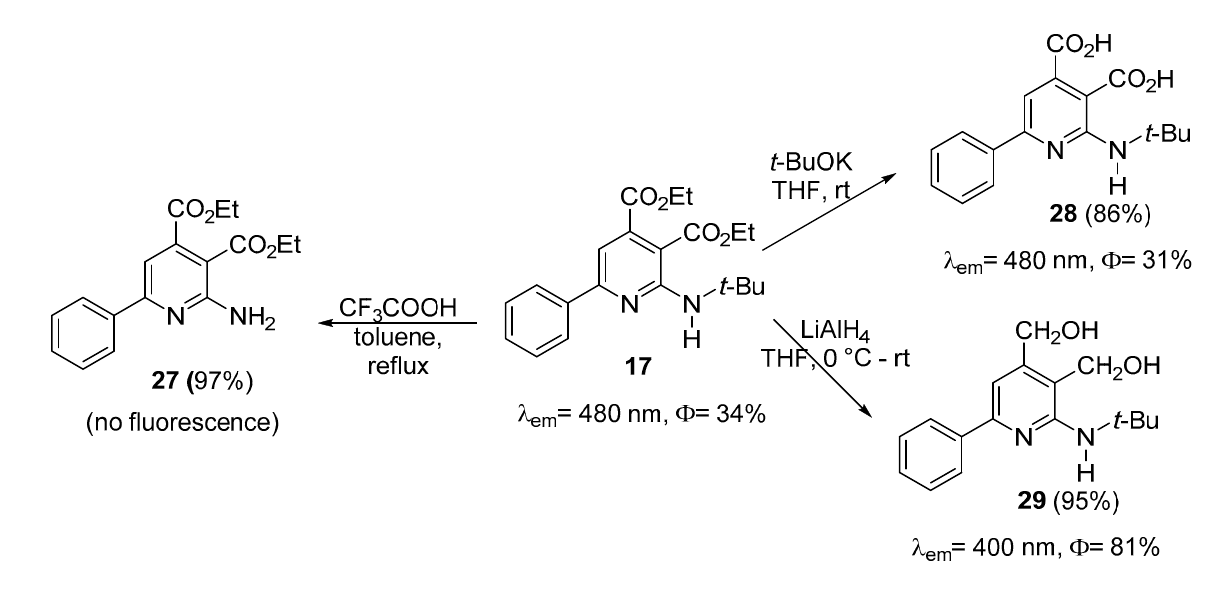
Scheme 7. Derivatization of multisubstituted aminopyridine 17